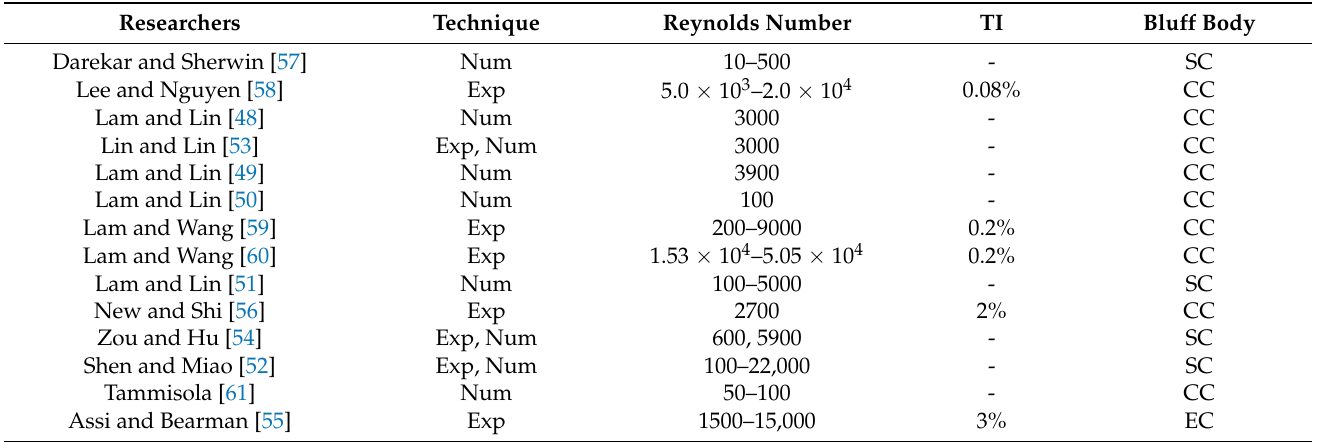
Table 4. Selected studies on flow control and suppression of vortex shedding wavy